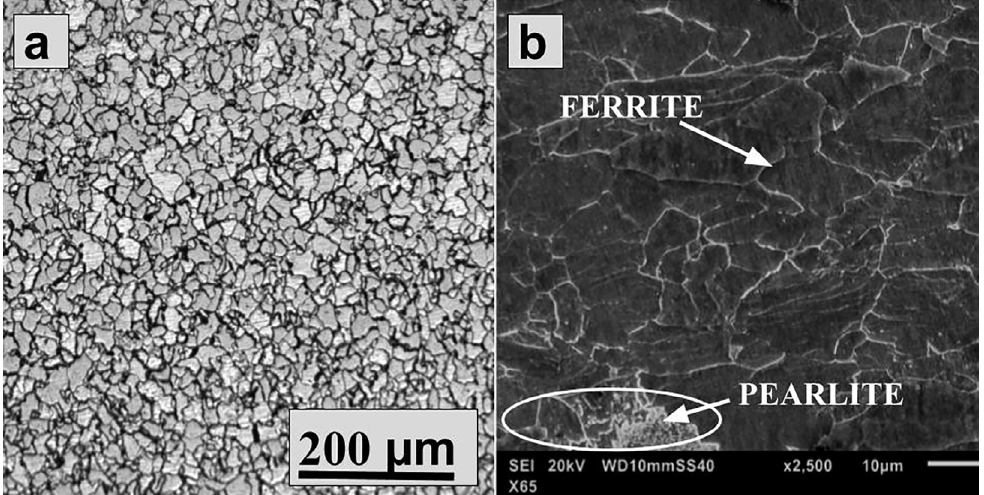
Figure 3. (a) Optical microscopy and (b) SEM (secondary electrons) image of the API 5L X65 steel. Images from the central cross-section to the rolling direction. Nital 2%